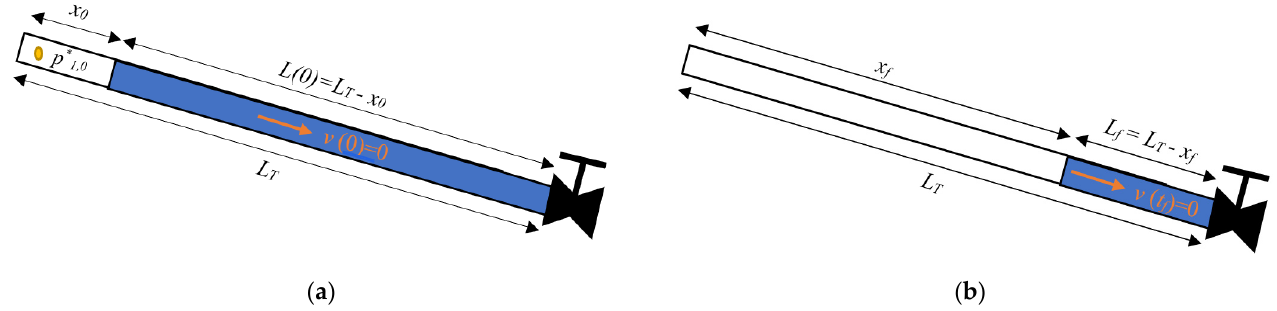
Figure 1. Schematic of an emptying process with a trapped air pocket in a single water pipeline: ( a ) initial condition and ( b ) final condition .